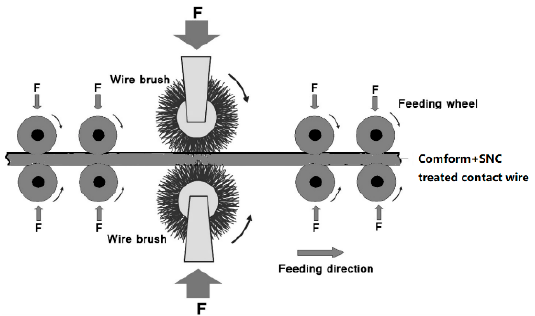
Figure 2. Schematic diagram of surface nanocrystallization.